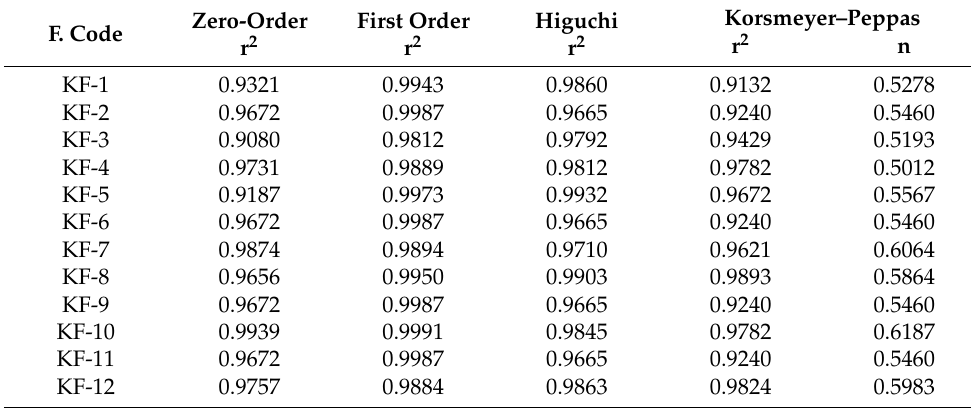
Table 3. Kinetic modeling of DS release from CS/CP/PVAcPAa hydrogels. F.